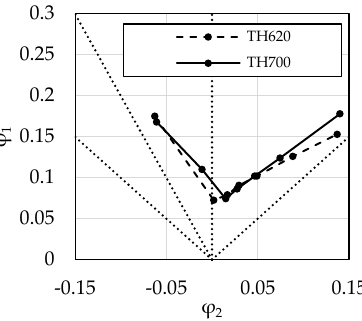
Figure 5. Forming limit curve for TH700 and TH620.